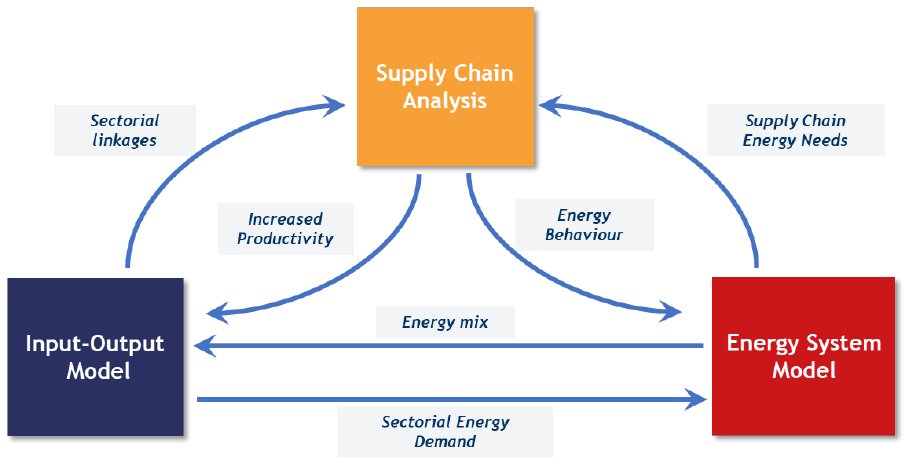
Figure 2. CIVICS Integrated Modeling Framework.